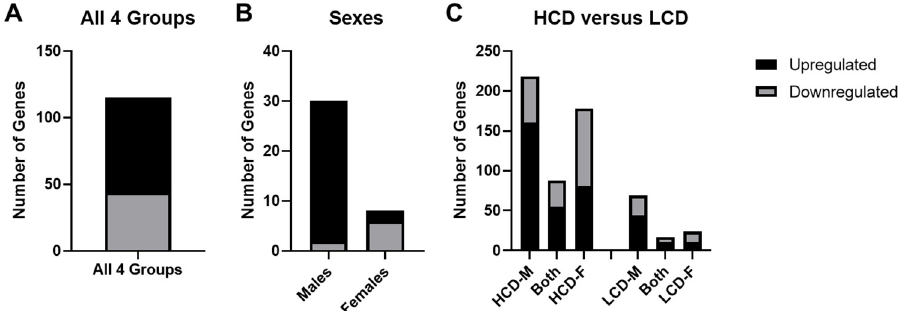
Figure 8. Upregulated and downregulated genes after ethanol exposure among different groups. ( A ) There were only 155 significant ethanol-induced gene expression changes that were similar between all four groups—71 upregulated, 44 downregulated. ( B ) Sex specific changes regardless of cell death profile were identified (males: 28 upregulated, 2 downregulated; females: 2 upregulated, 6 downregulated). ( C ) There were 484 unique genes that in the HCD strains (HCD-M only: 160 upregulated, 58; Both HCD-M & HCD-F: 55 upregulated, 33 downregulated; HCD-F only: 81 upregulated, 97 downregulated). There were 109 genes specific to LCD strains (LCD-M only: 44 upregulated, 25 downregulated; Both LCD-M & LCD-F: 11 upregulated, 6 downregulated; LCD-F only: 11 upregulated, 13 downregulated).